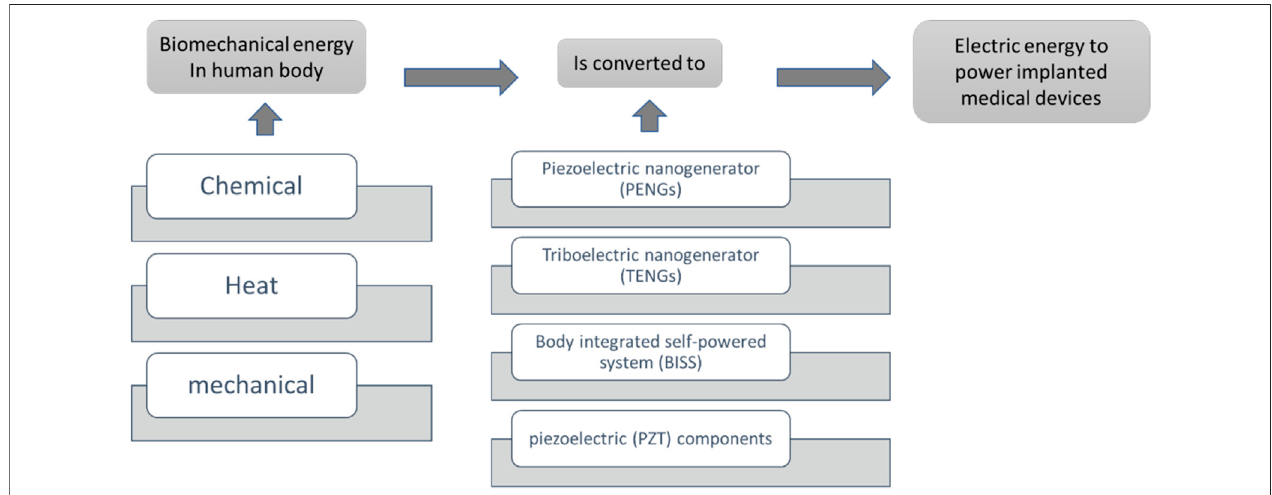
FIGURE 4 | Block diagram illustrates the conversion of various energies to power implanted